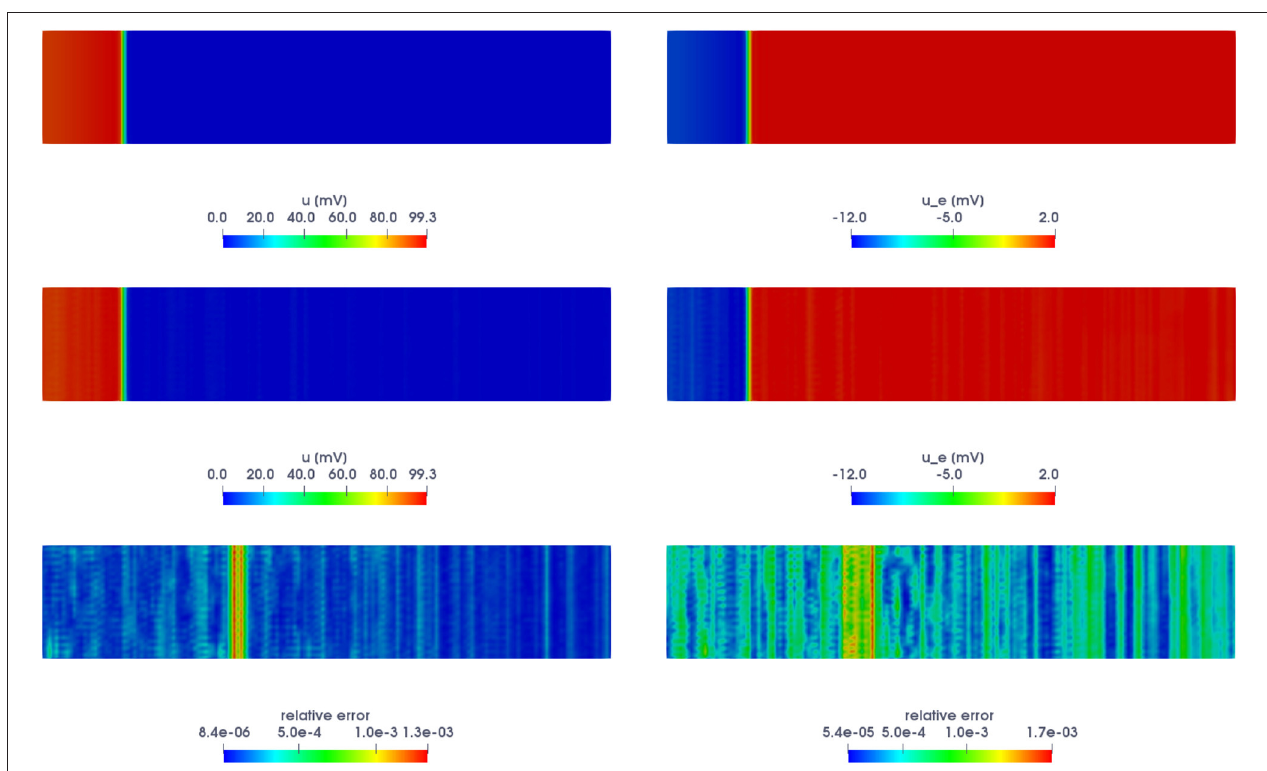
FIGURE 2 | Test 1.1 : FOM solution (top) and POD-DL-ROM one (center), with n = 2 and N = 256, along with the relative error ǫ k for u h (bottom-left) and u e , h (bottom-right), for the testing-parameter instance µ test = 0.0143 (cid:127) − 1 cm − 1 at t = 150